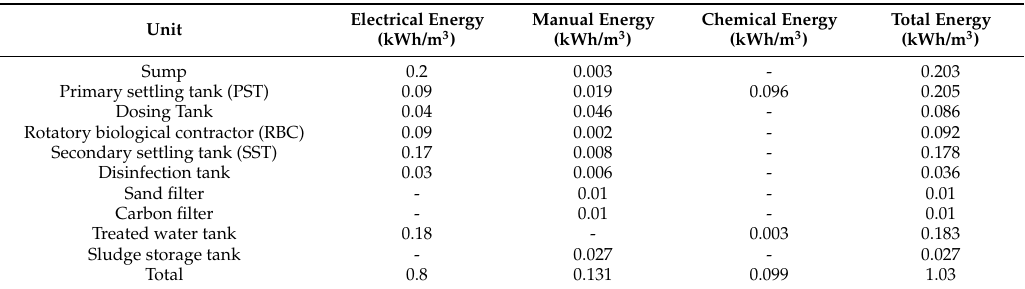
Table 14. Energy consumption from a small wastewater treatment plant WWTP